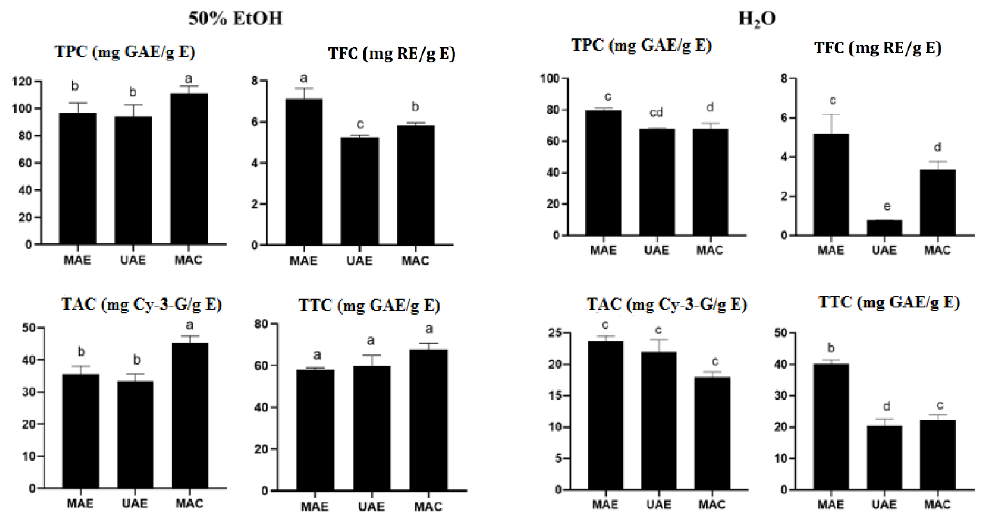
Figure 1. Total phenols, flavonoids, anthocyanins, and tannins content. GAE: gallic acid equivalent: RE: rutin equivalent; Cy-3-G: cyanidin- 3-O -glucoside equivalent. Values are reported as mean ± SD of three parallel experiments. Means followed by different letters (a – e) differ significantly at p < 0.05. MAE — microwave-assisted extraction technique; UAE — ultrasound assisted extraction technique; MAC — maceration.